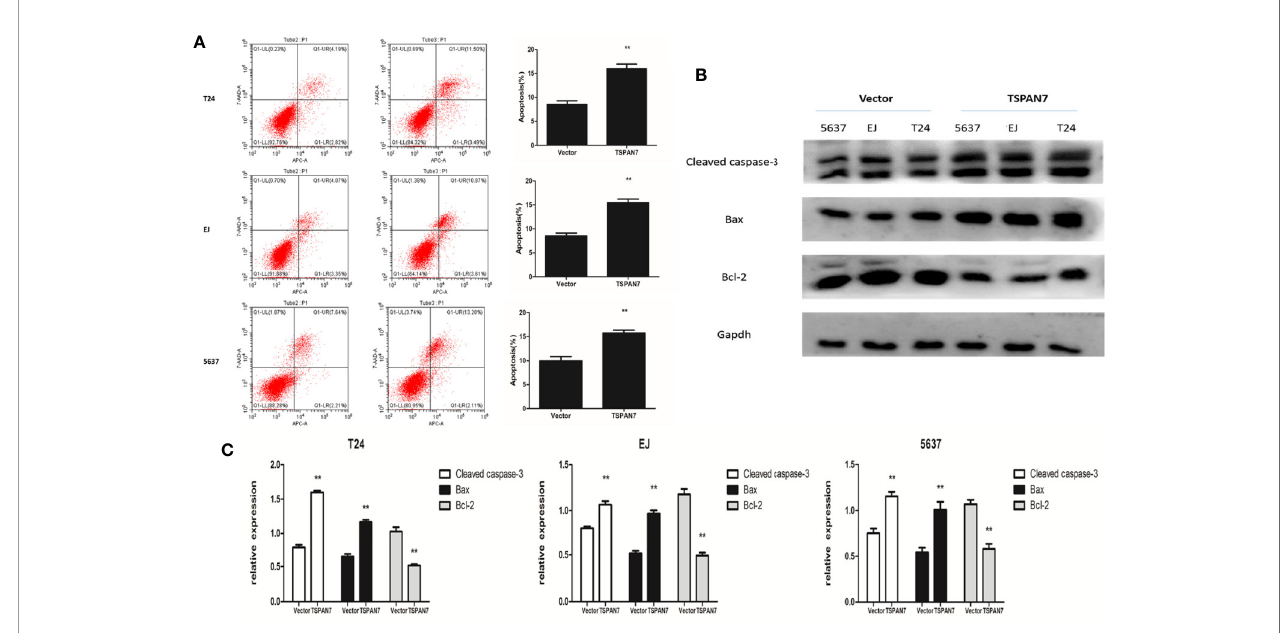
FIGURE 5 | TSPAN7 overexpression promotes the apoptosis of BCa cell. (A) Quantitative fl ow cytometry measurements of apoptosis in T24, EJ, 5637 cells. (B, C) TSPAN7 overexpression upregulated the expression of cleaved caspase-3 and Bax whereas that of Bcl-2 was downregulated. **p<0.01 vs. the control group. All the above data are the mean ± SD from an average of three experiments.